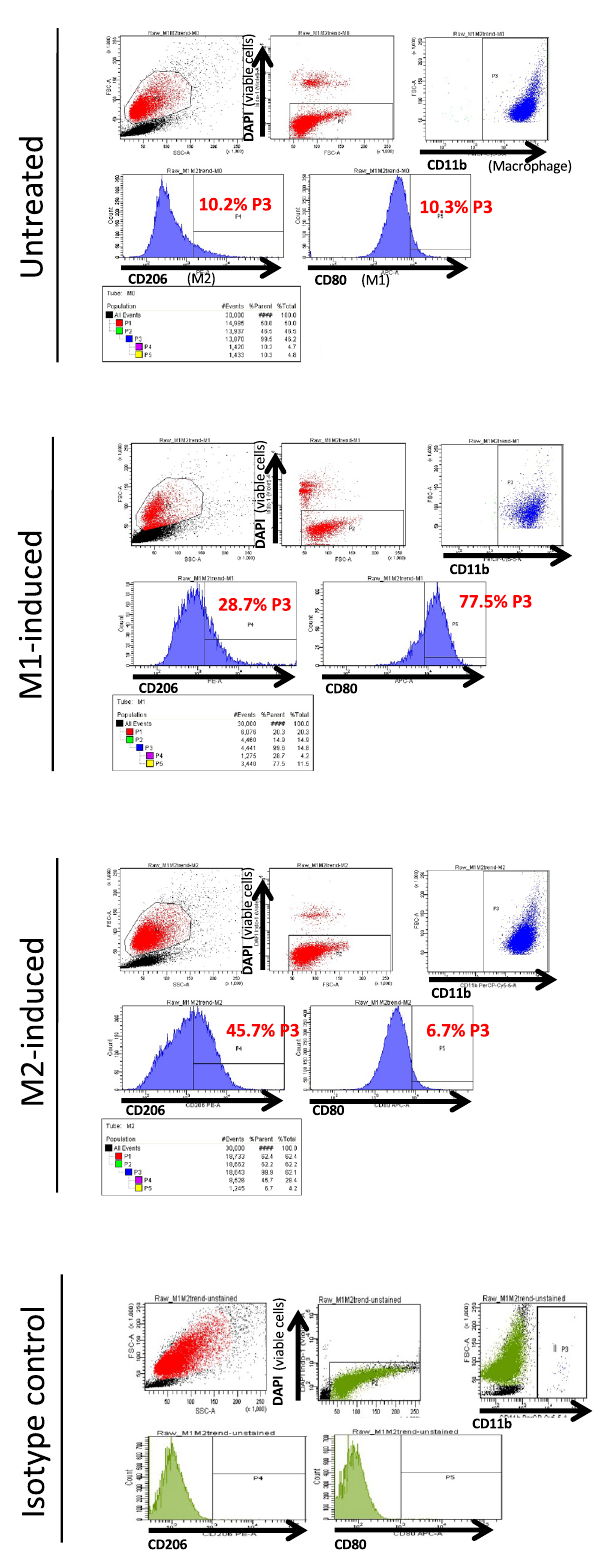
Figure 4. Confirmation of RAW264.7 cell polarization by flow